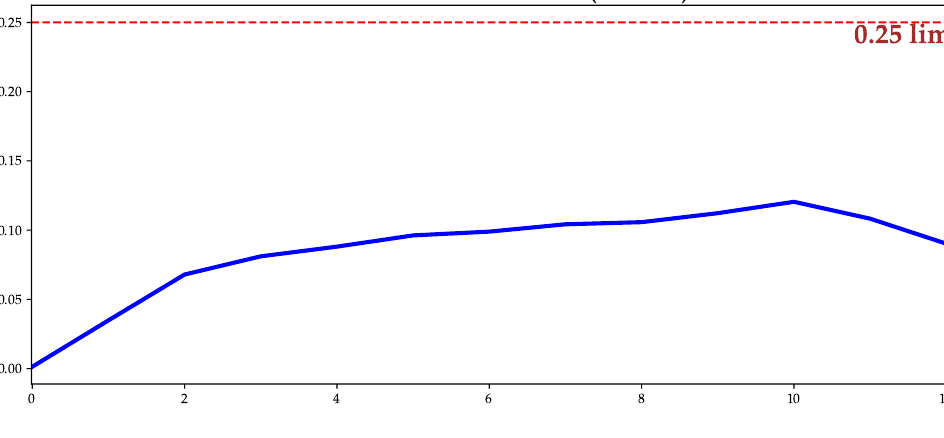
Figure 4. Global Model performance.